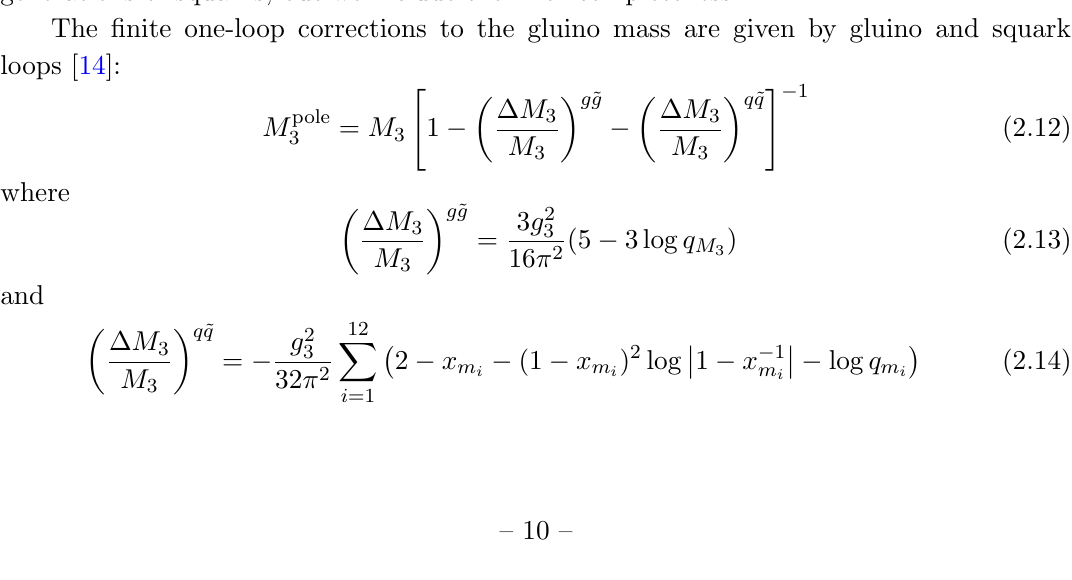
Figure 4 . The gluino tuning vs RG scale for a benchmark point m Q M 3 ((cid:3)) = 3 TeV, (cid:3) = 100 TeV, tan (cid:12) = 20. The dashed curve is derived from m 2 dependent tree-level term in (2.9). As can be seen, this is subject to large RG-scale uncertainty. The dotted curve shows the threshold corrections from V (1) and V (2) . Finally, the solid curve is the sum of the contributions to the tuning from m 2 stable across a wide range of Q